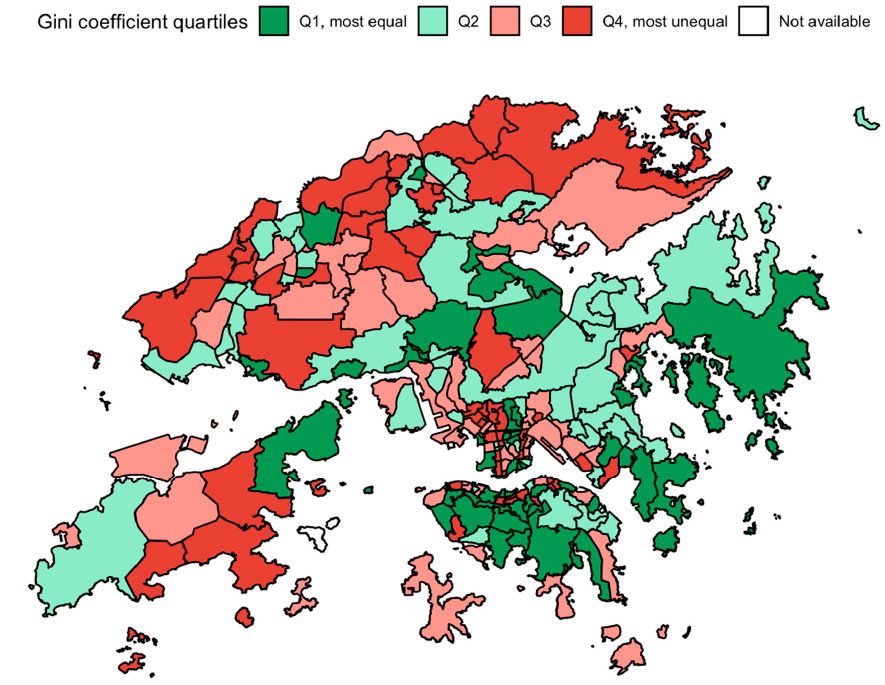
Figure 1. Gini coe ffi cients by tertiary planning units in 2011 in Hong